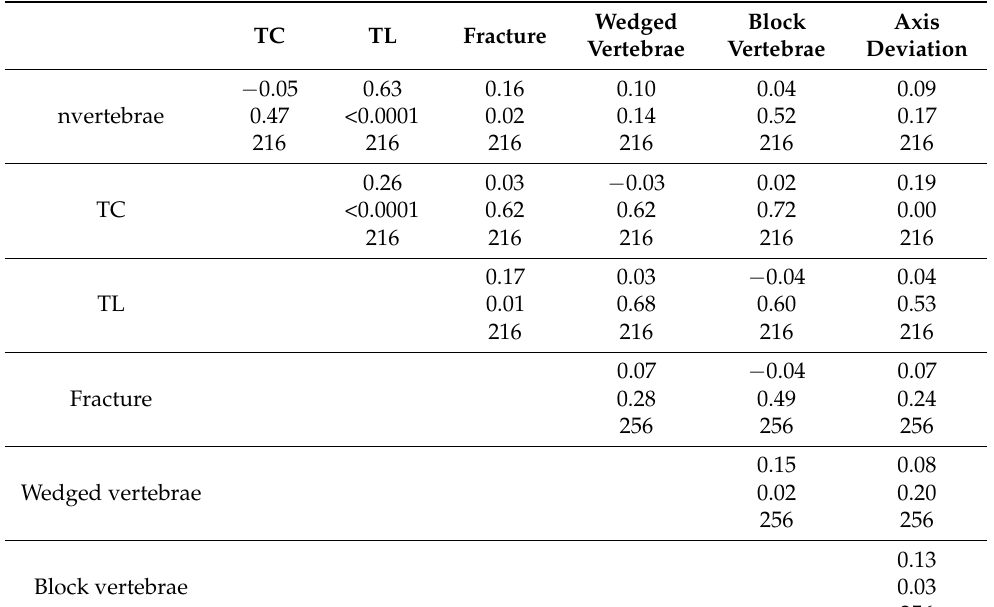
Table 5. Pearson correlation of tail length (‘TL’), tail circumference (‘TC’), number of vertebrae (‘nvertebrae’), occurrence of fractures, block and wedged vertebrae, and axis deviations in lambs. The Pearson correlation coefficient, the p -value, and the number of observations are reported.